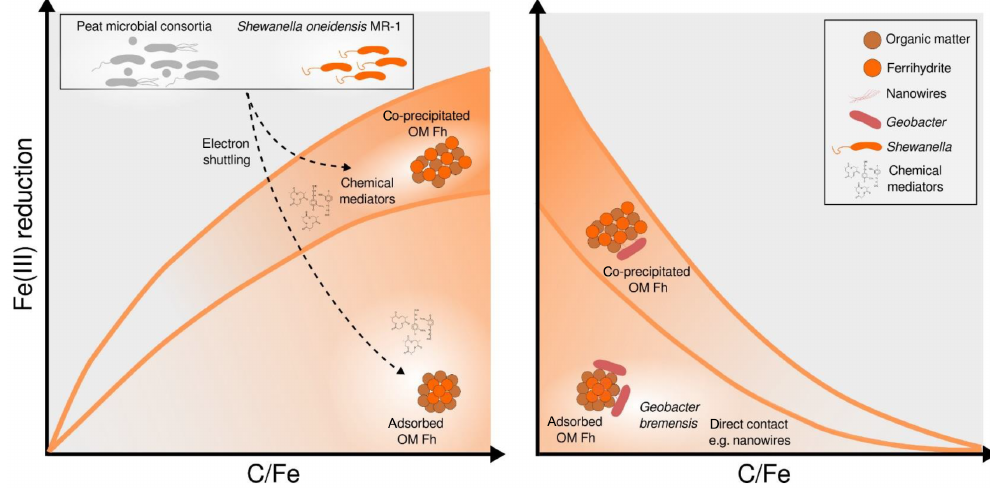
Figure 5. Microbial reduction of ferrihydrite with both adsorbed and coprecipitated OM by Shewanella oneidensis MR-1 and the micro- bial community consortia extracted from Schlöppnerbrunnen peat samples. For comparison, microbial reduction of ferrihydrite with both adsorbed and coprecipitated OM by Geobacter bremensis as described in Eusterhues et al. (2014) is depicted in the right